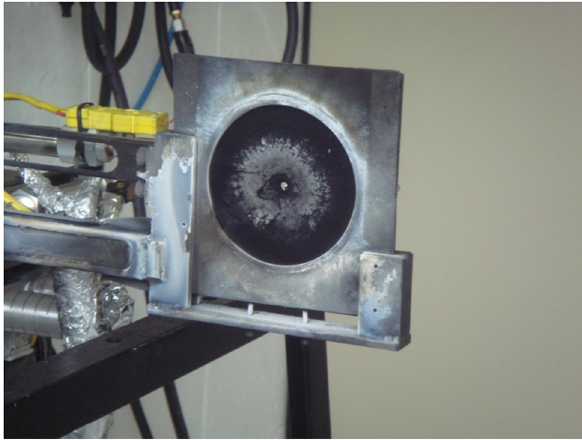
Figure 4: EPDM fi lled with 20% silica after the oxyacetylene torch test ( samples shown from ref. 29 ) .